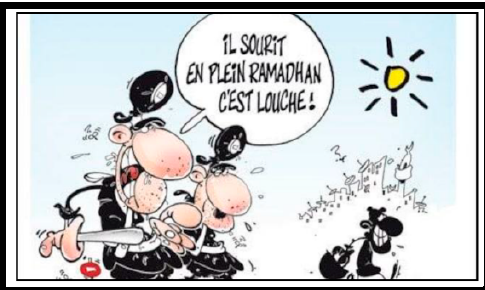
Figure 8. © L’Opinion.